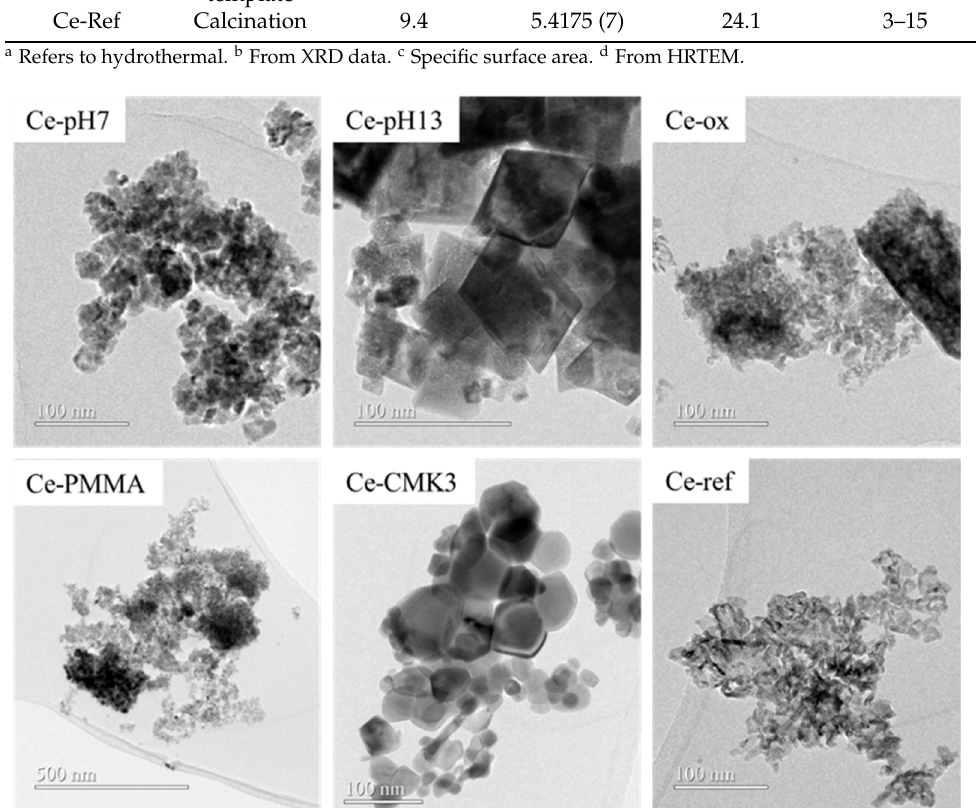
Table 1. Cell parameters, crystallite sizes and S BET values for the ceria samples.